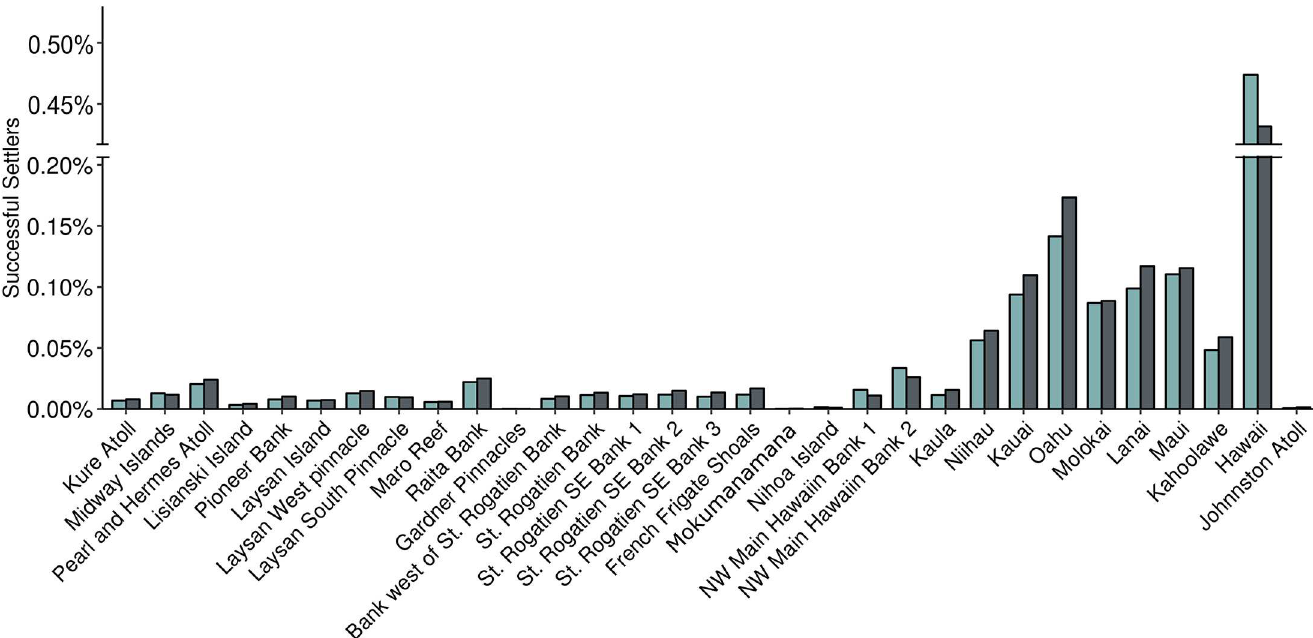
Fig 4. Total percent successful settlement at each island for the five-yearmodel run. Green bars show settlement for particles spawned during May- June, gray bars show settlement for